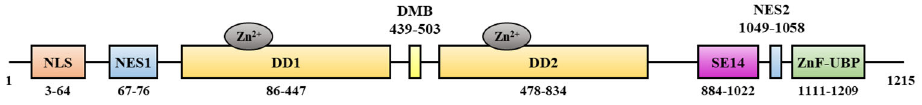
Figure 1. Functional domains of HDAC6. NLS, nuclear localization signal sequences; NES, nuclear export signal sequences; DD1/DD2, catalytic domains; DMB, dynein motor binding; SE14, Ser ‐ Glu